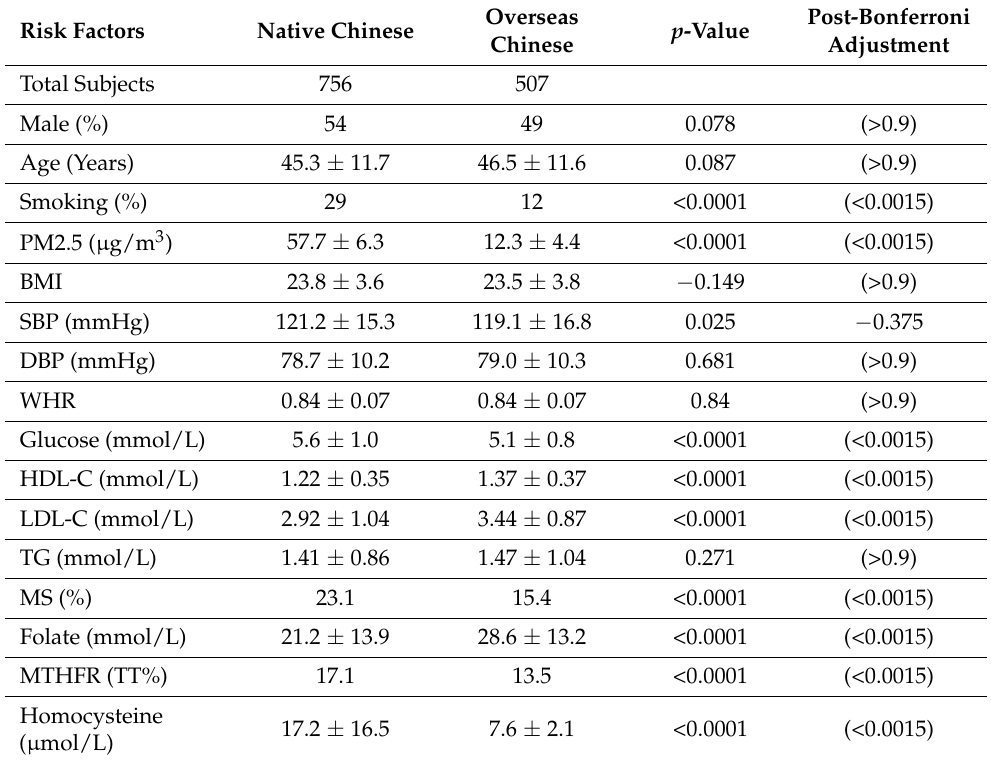
Table 3. Demographic and clinical characteristics of 1263 asymptomatic